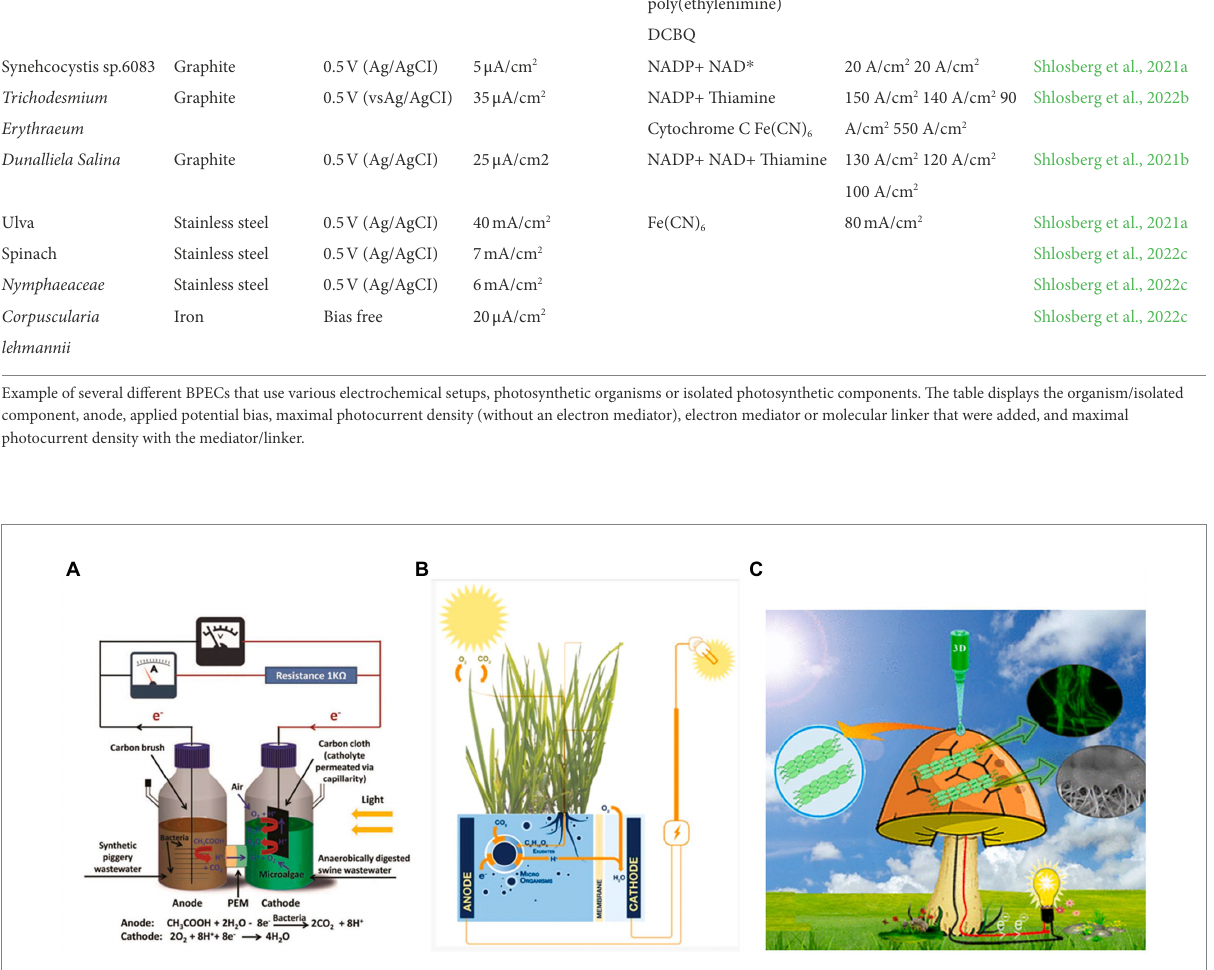
FIGURE 6 Hybrid synthetic BPECs exploit the symbiosis between different organisms. (A) A H-type BPEC that combines microalgae and microbial fuel cells (MFCs) from wastewaters. The MFC produces acetic acid that reduces the anode forming H + ions. The H + ions cross the PEM and together with the O 2 produced by microalgal photosynthesis, oxidize the anode to form water. Reprinted with permission from Ling et al. (2019). (B) Plants-MFC hybrid system. Leaves conduct photosynthesis to produce glucose. The glucose is released into the soil by the roots and feed bacteria that reduce the anode placed in the soil. Reprinted with permission from Strik et al. (2008). (C) Cyanobacterial colonies are 3D-printed on a mushroom with graphene nanoribbons. The mushroom applies as a biocompatible substrate for cyanobacterial growth. Reprinted with permission from Joshi et al.